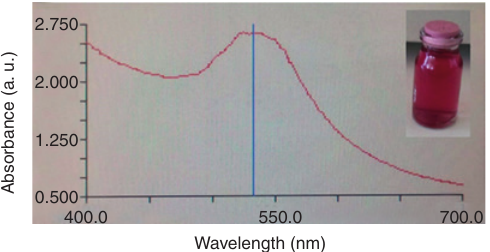
Figure 2: A UV-Vis spectra sample of the mixture solution contain- ing HAuCl and mushroom extract, after synthesis of AuNPs. 4